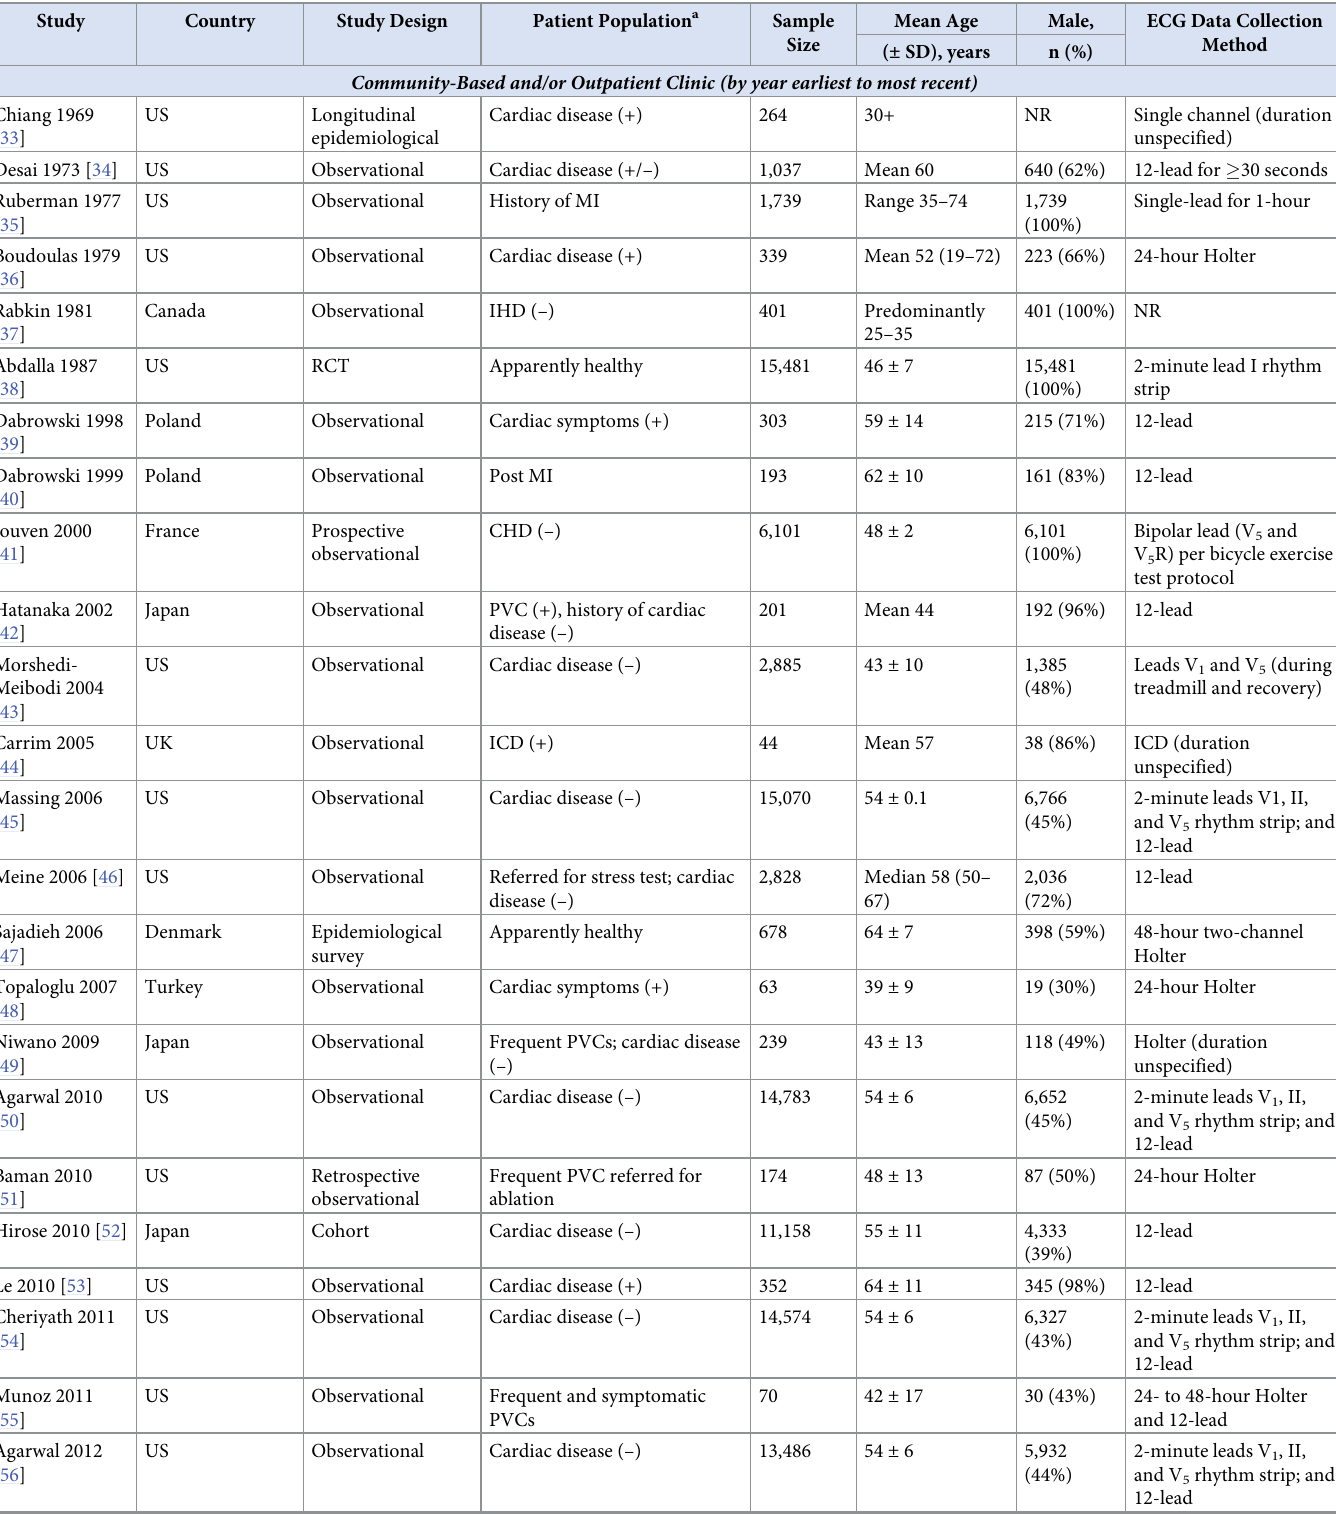
Table 2. Characteristics of the studies included in the scoping review grouped by setting (i.e., community-based/outpatient clinic or hospital).